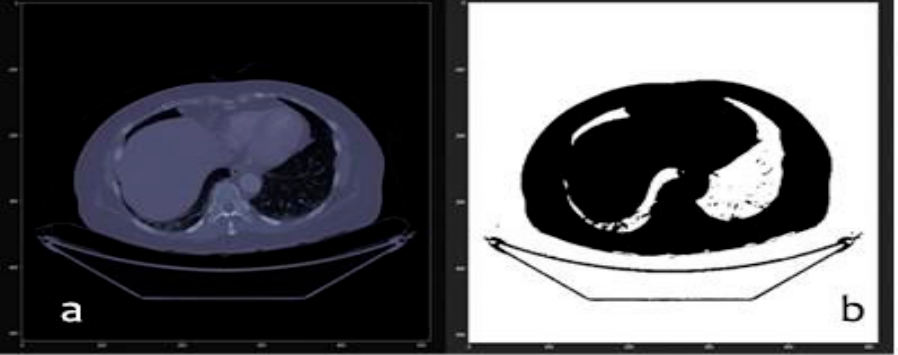
Figure 6. ( a ) Original slice number 100 and ( b ) thresholded slice number 100 of LIDC-IDRI-0121.